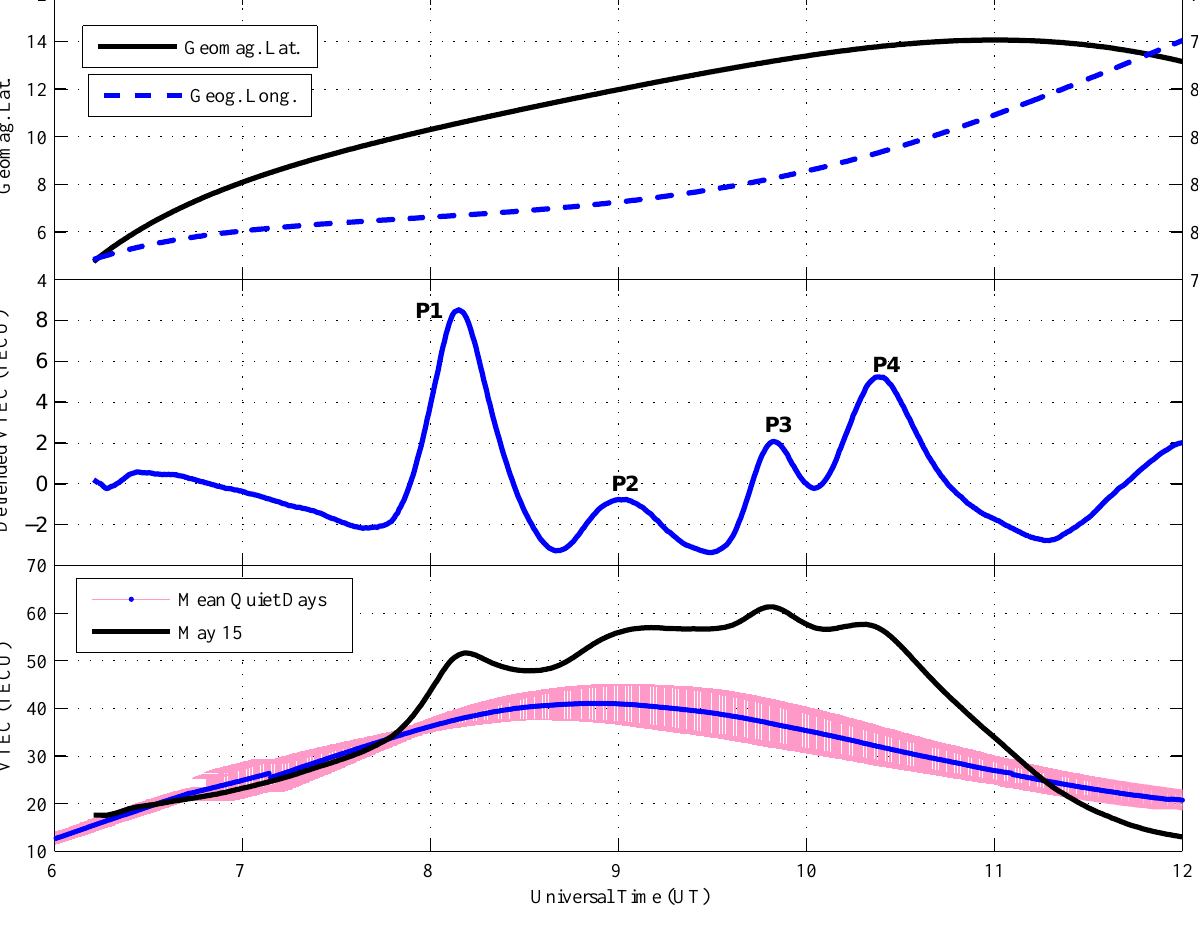
Fig. 4a. VTEC observations from Hyderabad for PRNs 14. Rest is the same as Fig.